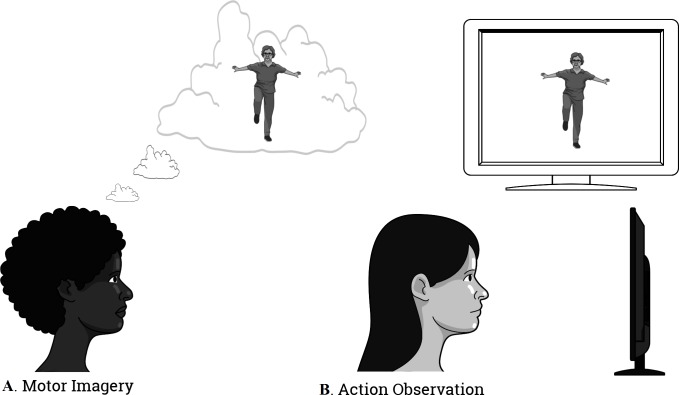
The illustration of the intervention.(A) Motor Imagery; (B) Action Observation Training.